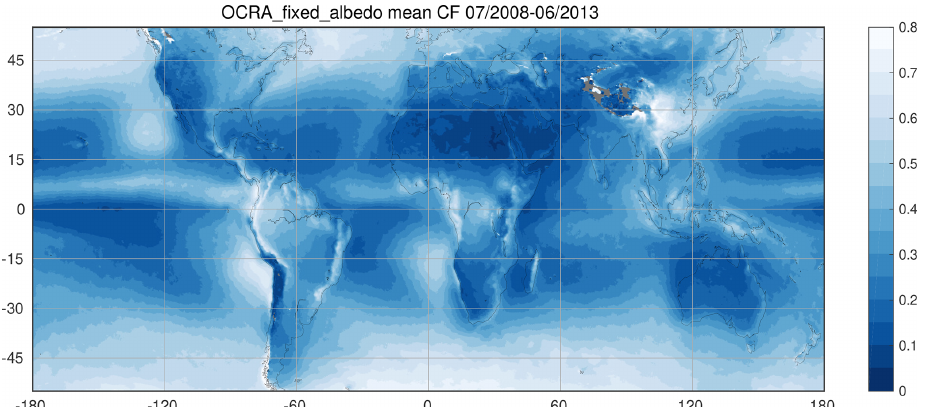
Figure F7. Same as Fig. 14 but showing the 5-year average of the OCRA_fixed_albedo cloud fraction measurements recorded between 1 July 2008 and 30 June 2013. Areas without data are plotted in gray.